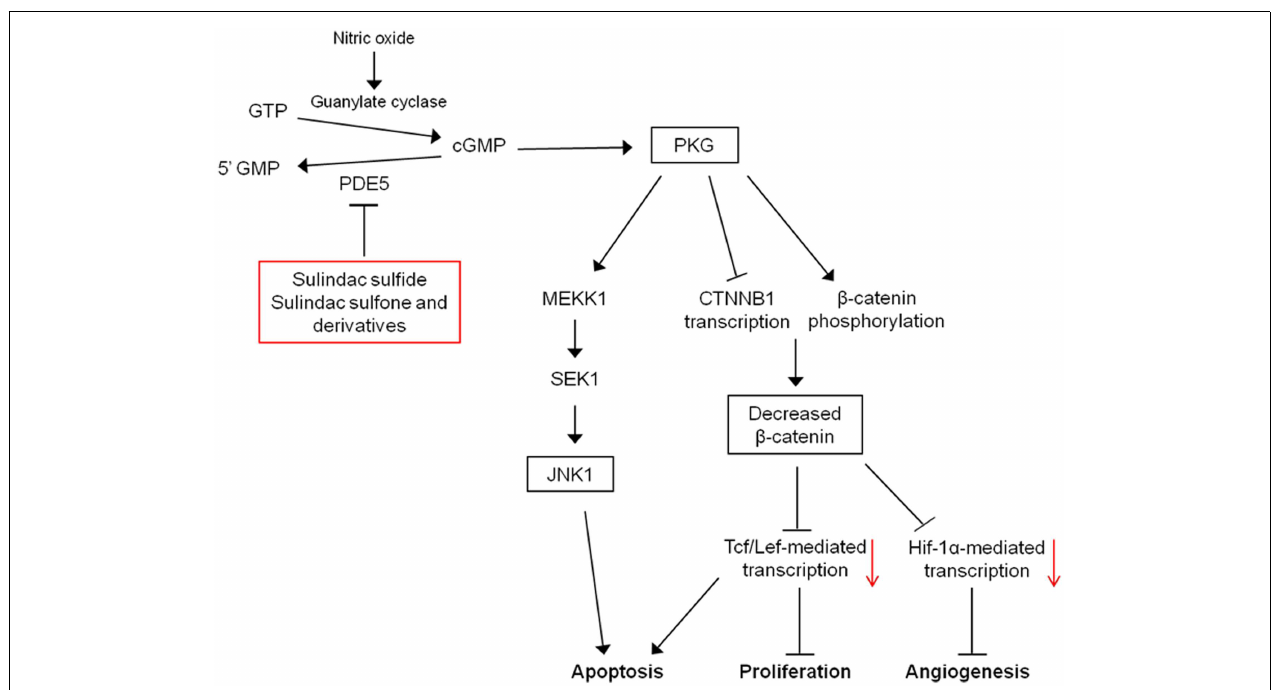
protein kinase G. PKG activation can lead to the induction of apoptosis, and inhibition of proliferation and angiogenesis through activation of JNK1 and downregulation of β -catenin-mediated